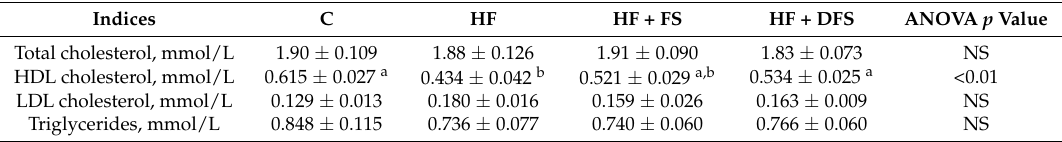
Table 4. Blood lipid profile in